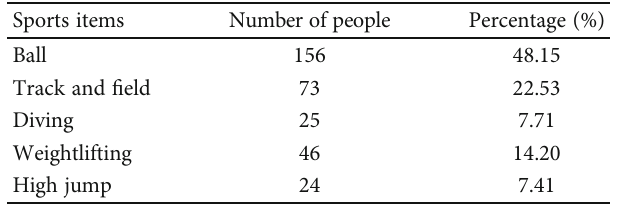
Table 1: Sports preference